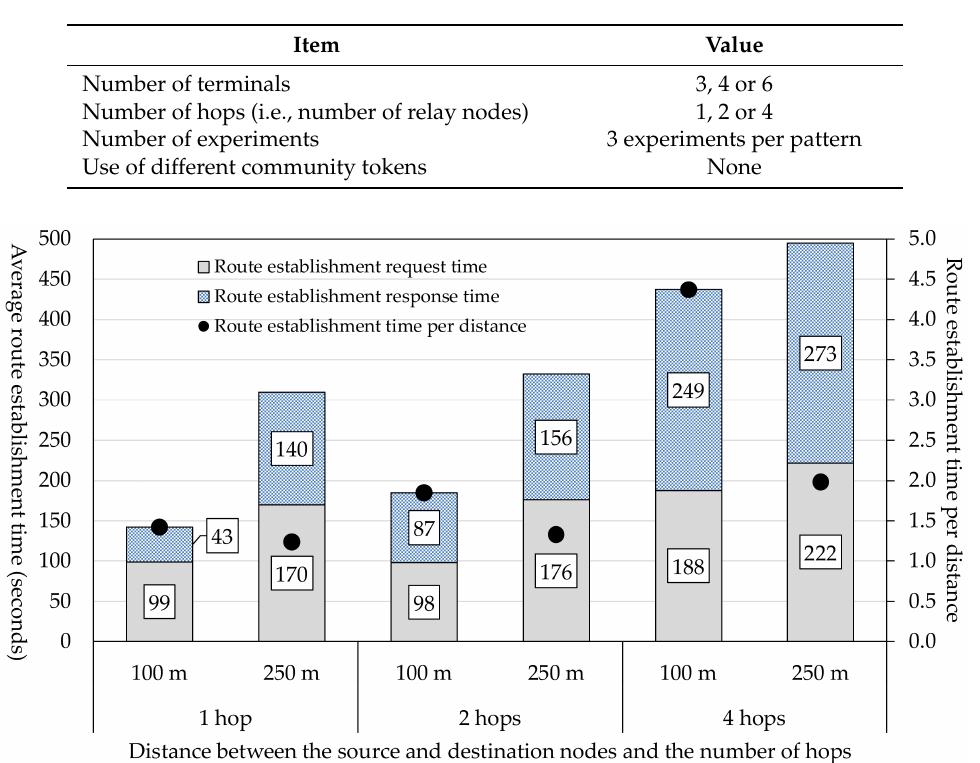
Figure 10. Required route establishment